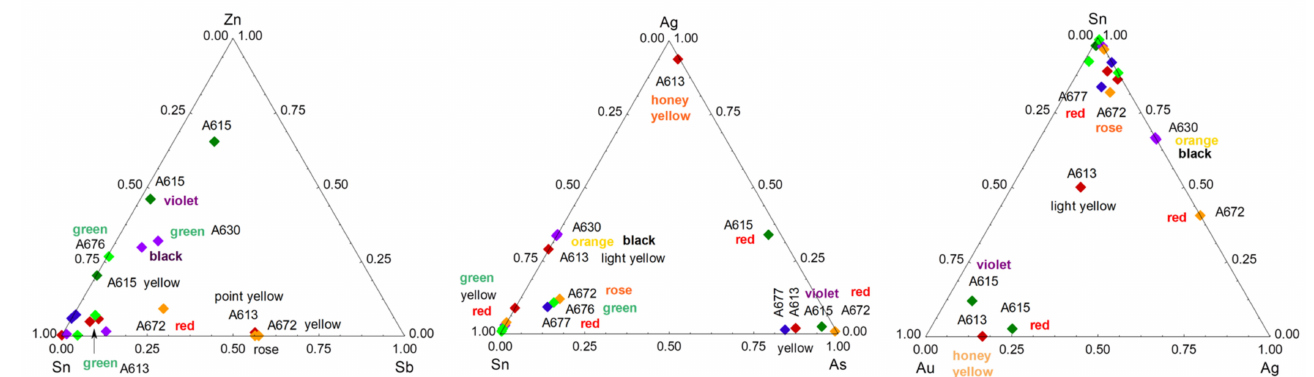
Figure 12. Comparison of the net number of photons of the elements Pb, Ca, K, Cu, As, Au, Sn, Ag, Sb, and Zn measured on the colored areas. Objects with special characteristics are indicated (see Table 1). Different colored lozenges are used to present the different objects (A677 blue, A613 dark red, etc.). The color indicated in the plots corresponds to that of the studied area ( red , violet , honey yellow , orange , green , rose , yellow, and black